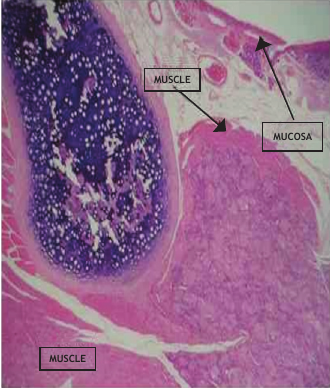
Figure 2 Photomicroscopy of rabbit right vocal fold 3